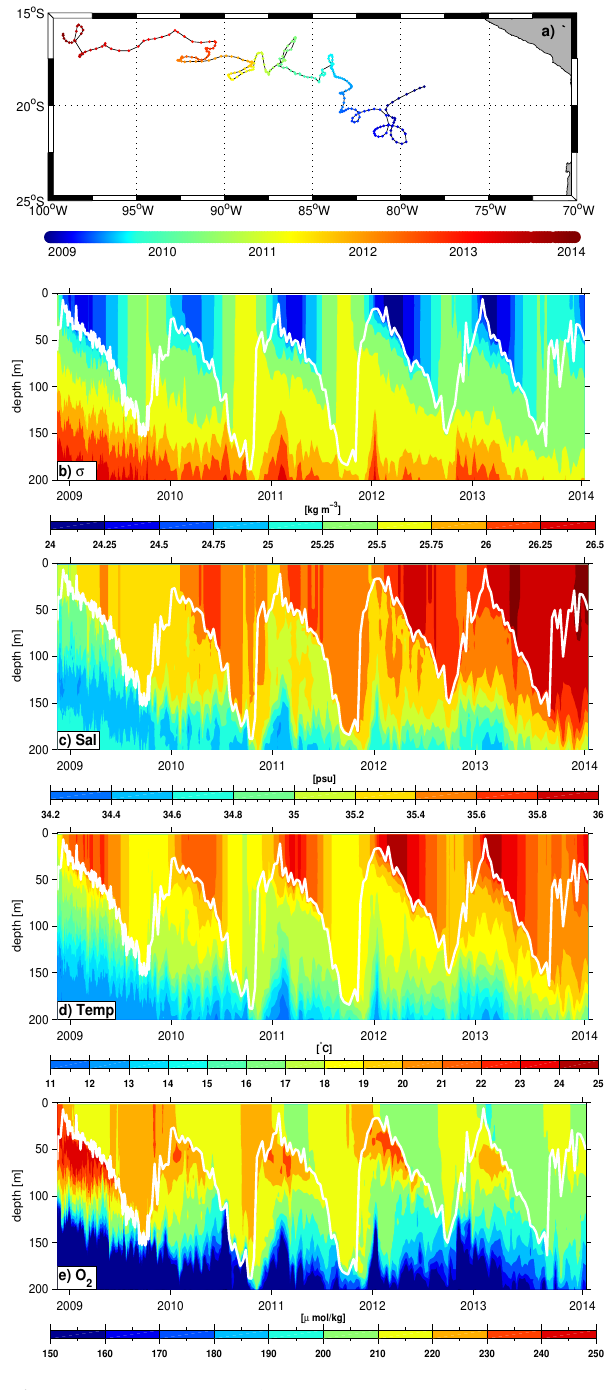
Figure 8. Measurements of float 3900727 in the tropical eastern South Pacific for the period 17 November 2008 to 11 February 2014 with (a) float path (color coded) and the distribution in the upper 200m depth for (b) potential density anomaly, (c) salinity, (d) po- tential temperature, and (e) oxygen. The white curve in (b–e) is the mixed layer depth defined for the depth where the potential density anomaly is 0.125kgm − 3 larger than at the